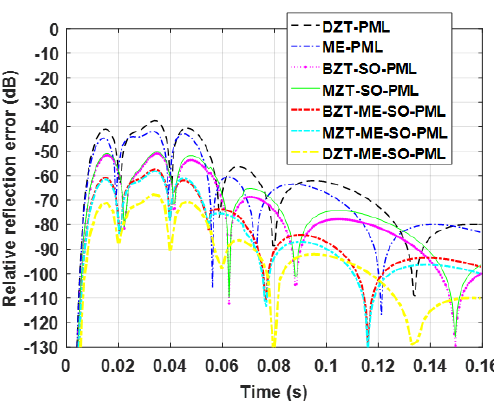
Figure 3. Relative reflection error versus time for a smaller physical domain.